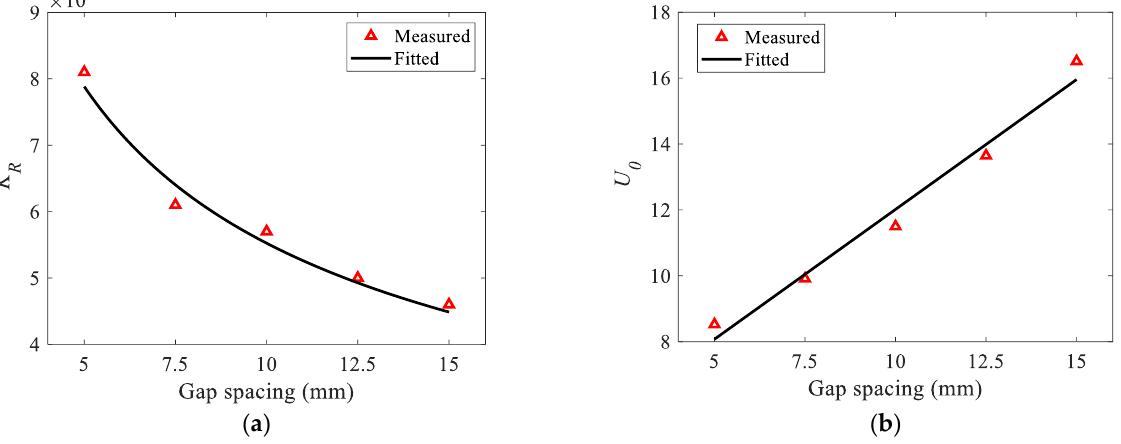
Figure 10. Measured and fitted results of K R and U 0 with varying gap spacing: ( a ) K R ; ( b ) U 0 . The solid lines are the least squares fitting lines.